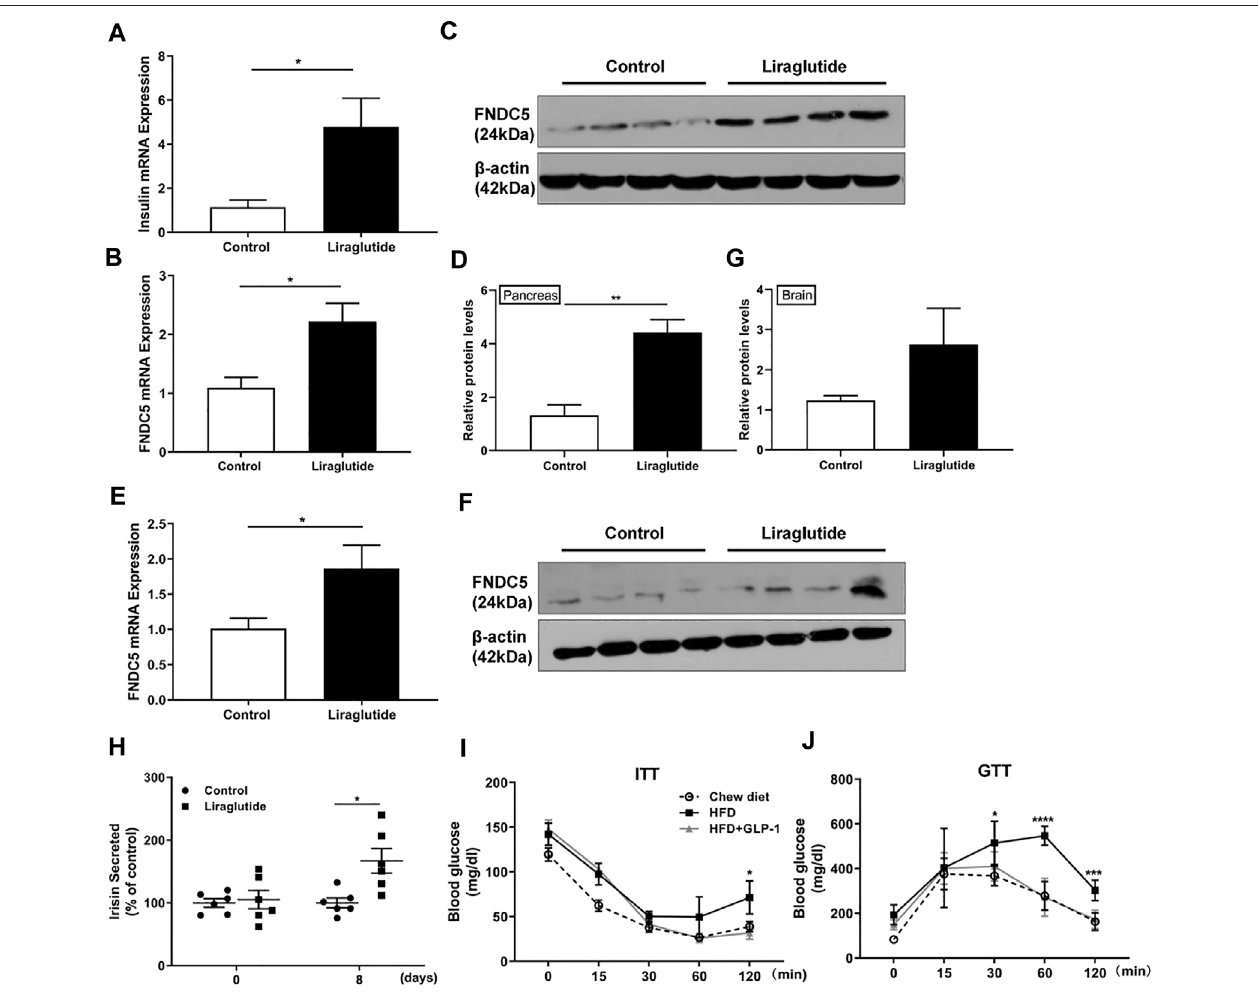
FIGURE 2 | GLP-1 upregulates FNDC5 gene expression in mouse pancreas and brain tissue. C57BL/6 mice ( n (cid:1) 4 – 6) were fed with chow diet and treated with eitherliraglutide(1 μ g/g)orsalineascontroloncedailybyi.p.injection.Pancreasandbraintissueswerecollectedfrommiceafter8 daysoftreatment. (A) Theexpression of the insulin gene was measured in the pancreas. The expression levels of FNDC5 mRNA and protein in the pancreas (B – D) and brain tissues (E – G) were analyzed by RT-qPCRandwesternblotting.Theexpressionlevelincontrolwassetas1fornormalization. β -Actinexpressionwasusedasacontrolinwesternblottinganalysis. (H) The serum levels ofsecreted irisin intwo mice groups ( n (cid:1) 6) were measured byELISA. The level in the control wasset as100% for normalization. (I , J) HFD-induced obeseC57BL/6miceweretreatedwithliraglutidefor14 daysandITTandGTTwereperformed( n (cid:1) 6 – 8).Valuesaremean ± SEM.* p < 0.05,** p < 0.01,*** p < 0.001and **** p <